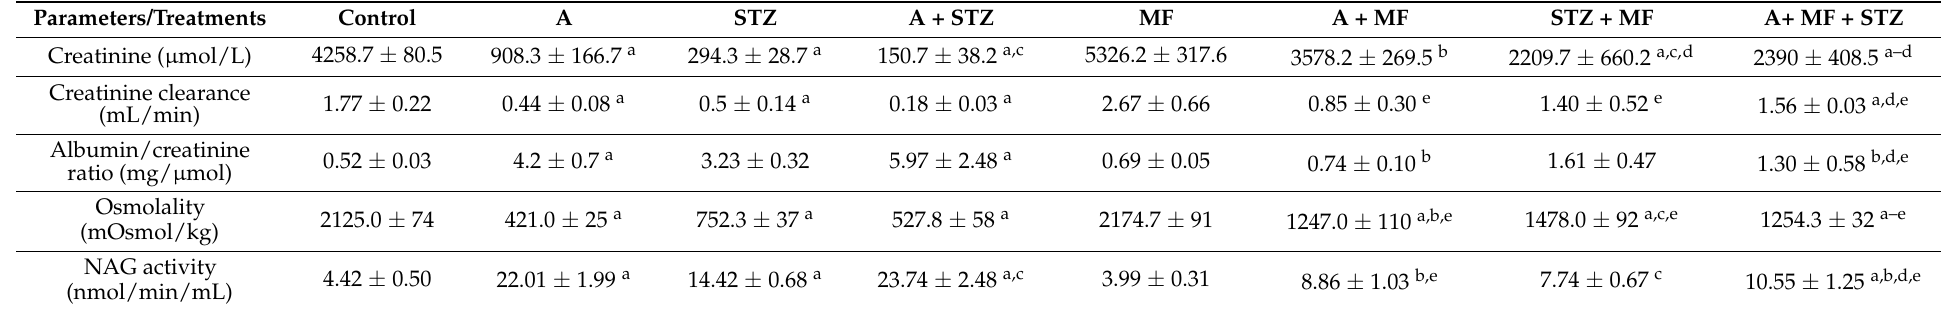
Table 3. Effect of metformin (MF) treatment on some urine parameters in diabetic and non-diabetic rats with adenine (A)-induced chronic kidney disease (CKD). Parameters/Treatments